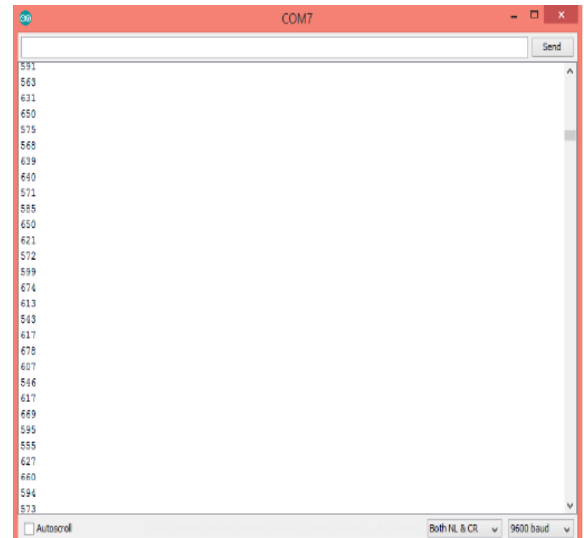
Figure 9. ECG Values on COM 7